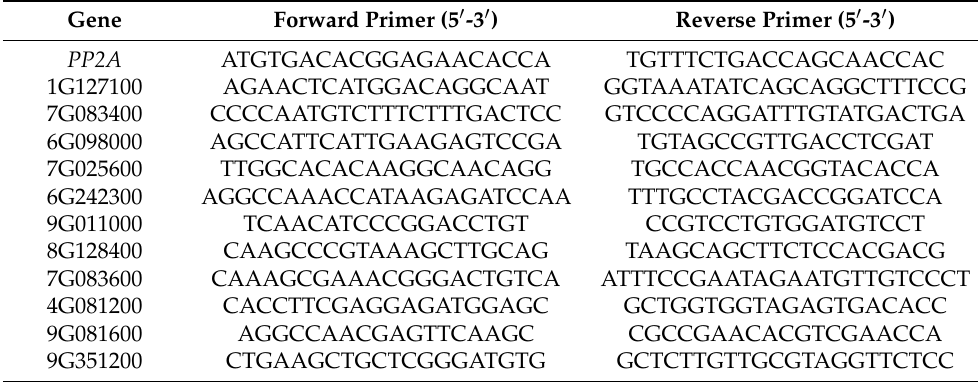
Table 6. Sequences of the primers used in this study.